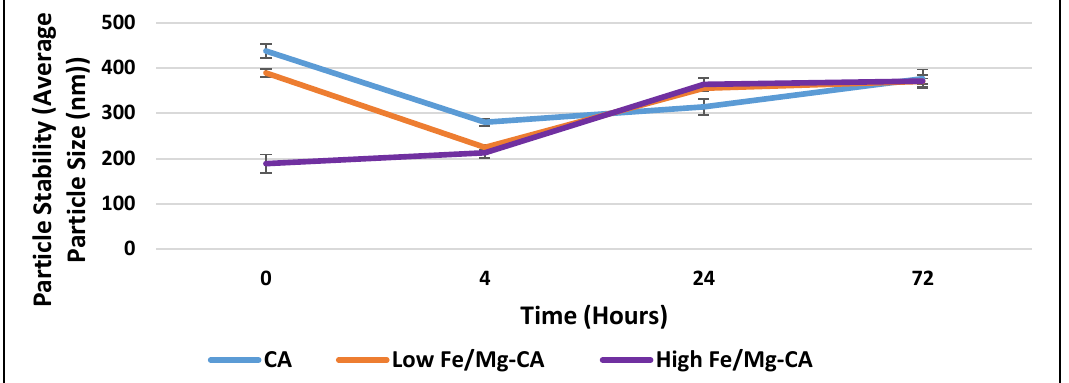
Figure 5. Stability analysis of CA, low Fe/Mg-CA and high Fe/Mg-CA NPs based on measurement of z-average diameter over a period of 72 h. The temperature of 37 °C was maintained throughout the experiment.